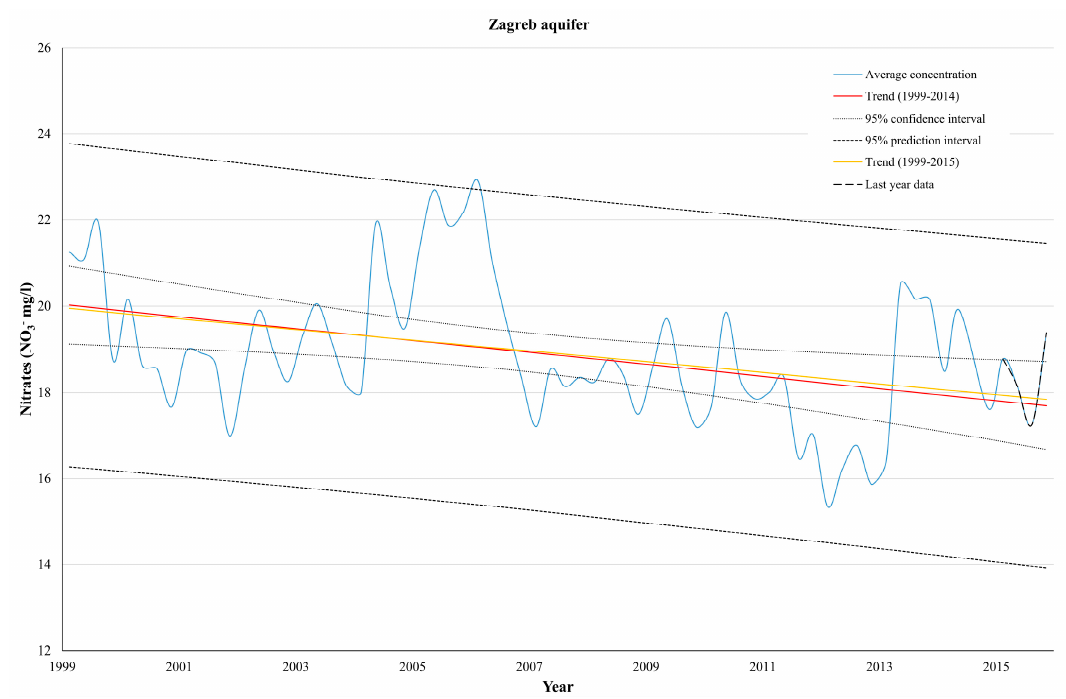
Figure 7. Trend estimation without data smoothing for the whole aquifer.